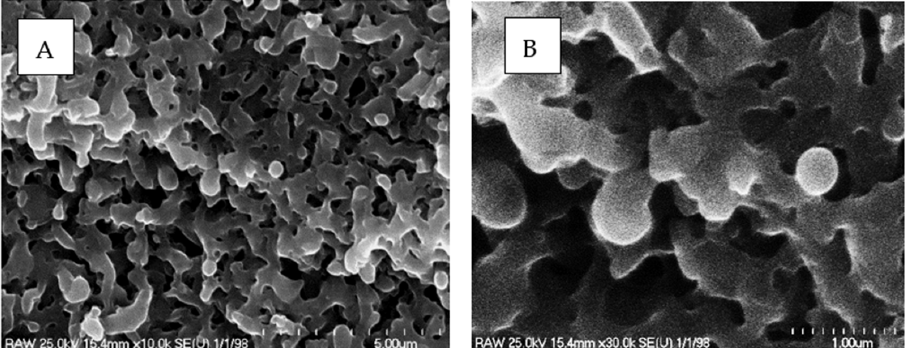
Figure 2. Scanning electron microscope (SEM) analysis of porous layer at different magnifications: ( A ) 10 K; ( B ) 30 K.